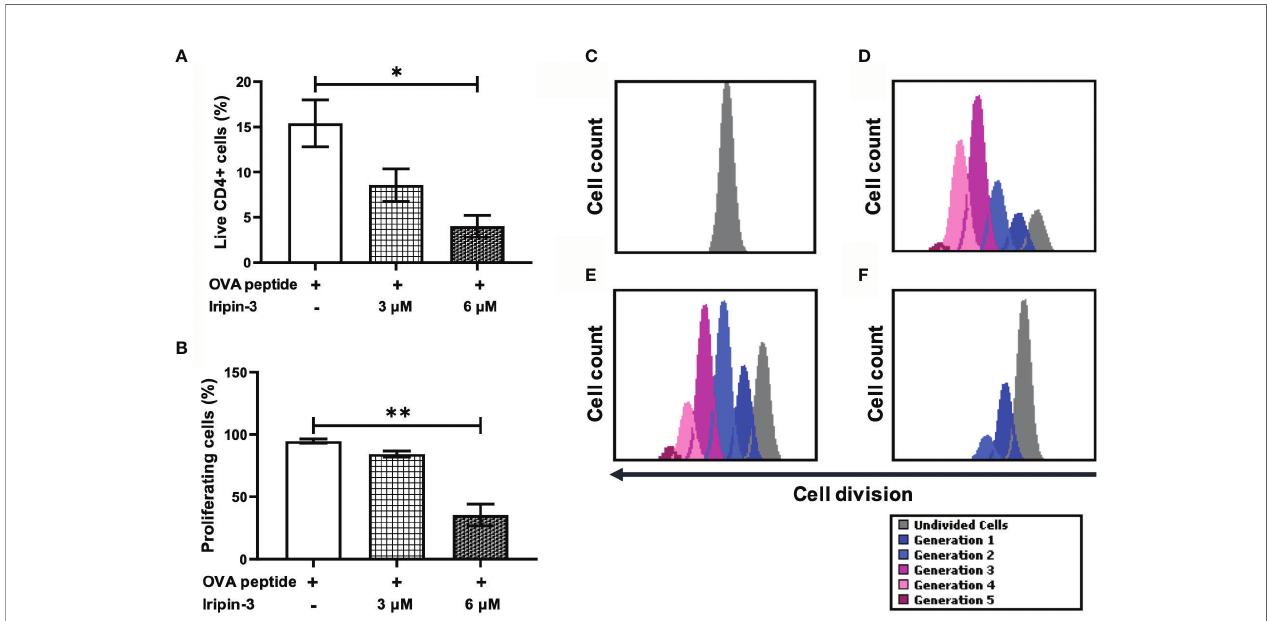
FIGURE 9 | Iripin-3 impairs the survival and proliferation of CD4 + splenocytes. (A, B) The percentage of live CD4 + cells (A) and the percentage of proliferating live CD4 + cells (B) after exposure to 3 m M or 6 m M Iripin-3. Cells not treated with Iripin-3 were used as control. After 2 h pre-incubation with Iripin-3, cells were cultured in the presence of OVA peptide (100 ng/ml) for 72 h. Data are presented as mean ± SEM of three independent experiments (*p < 0.05, **p < 0.01). (C – F) Histograms showing the number of live CD4 + cells that managed to divide once (blue), twice (light blue), 3 times (pink), 4 times (rose), 5 times (plum), or did not divide at all (gray) within the 72 h culture period. Cells were incubated in the absence of Iripin-3 and OVA peptide (C) , in the presence of OVA peptide only (D), or were treated with the combination of 3 m M Iripin-3 and OVA peptide (E) or 6 m M Iripin-3 and OVA peptide (F)